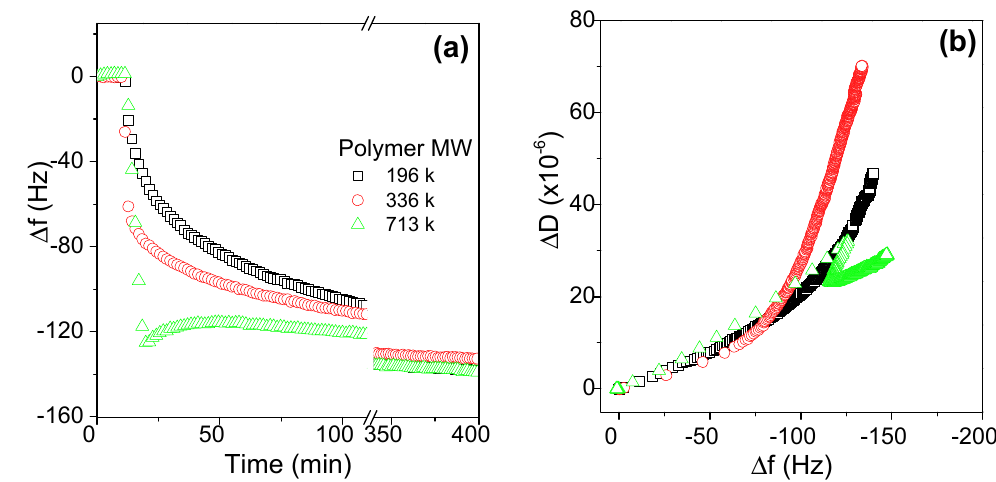
Figure 2. Effects of molecular weight of AmPAM samples on the adsorption amount ( a ) and conformation ( b ) of the AmPAM adlayers on silica substrate. Three tested AmPAM samples were of MW of 196, 336, and 713 k, respectively. The AmPAM solutions were of concentration of 100 mg / L and ionic strength was controlled at 0.02 M.